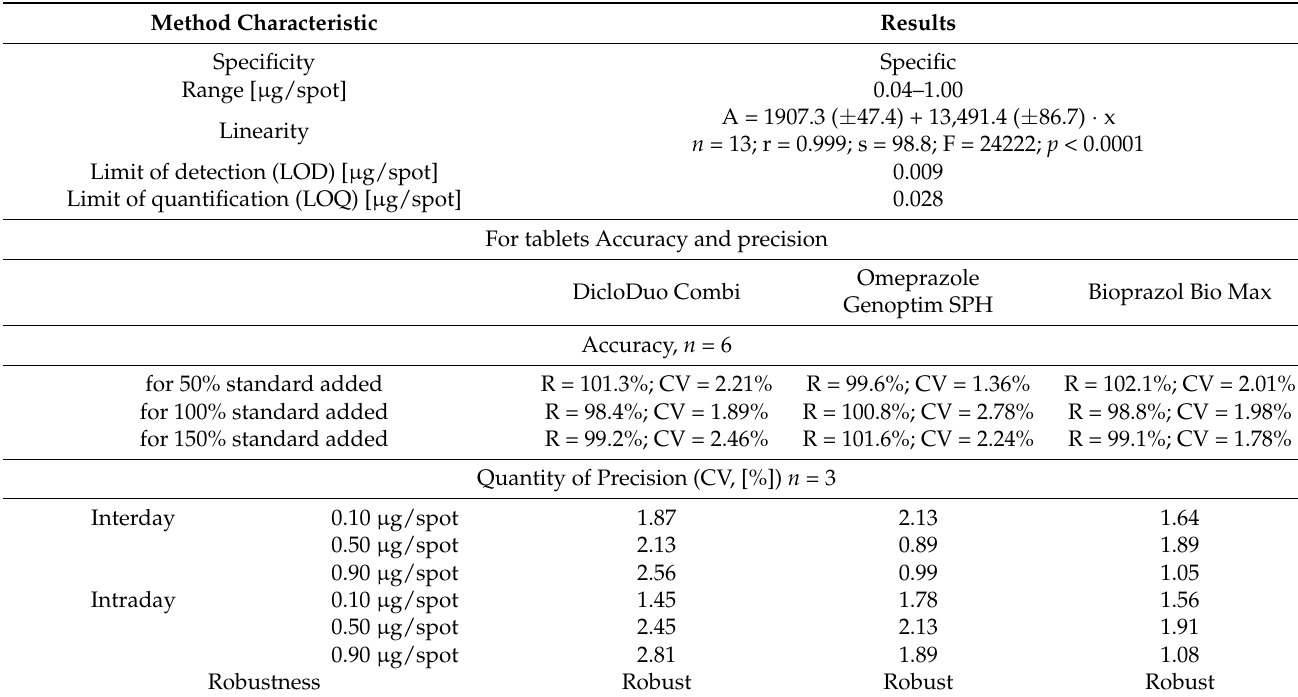
Table 4. Method validation data for the quantitative determination of omeprazole by NP-TLC with densitometry after separation using chloroform–methanol–ammonia (36:4:0.60 v / v / v ).